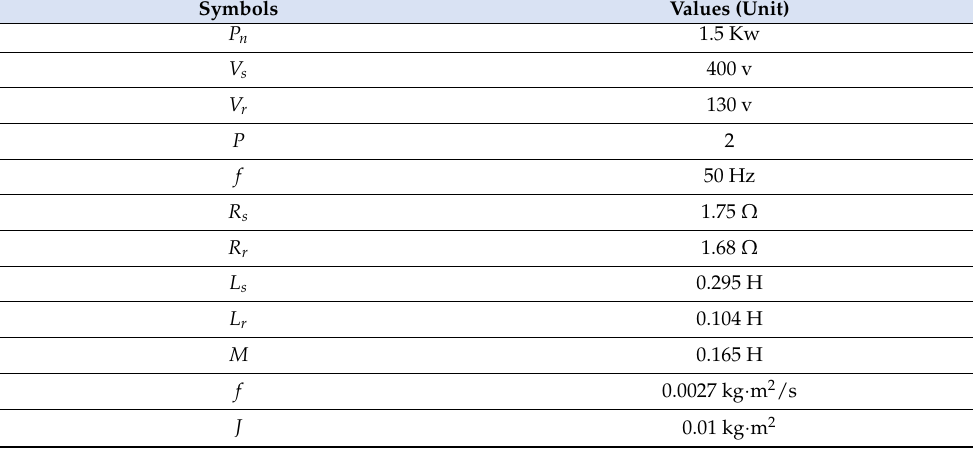
Table A1. Specifications of the DFIM.